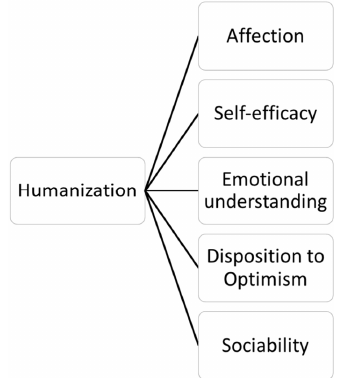
Figure 1. Explanatory theoretical model of the humanization construct in the Healthcare Professional Humanization Scale (HUMAS) Model.